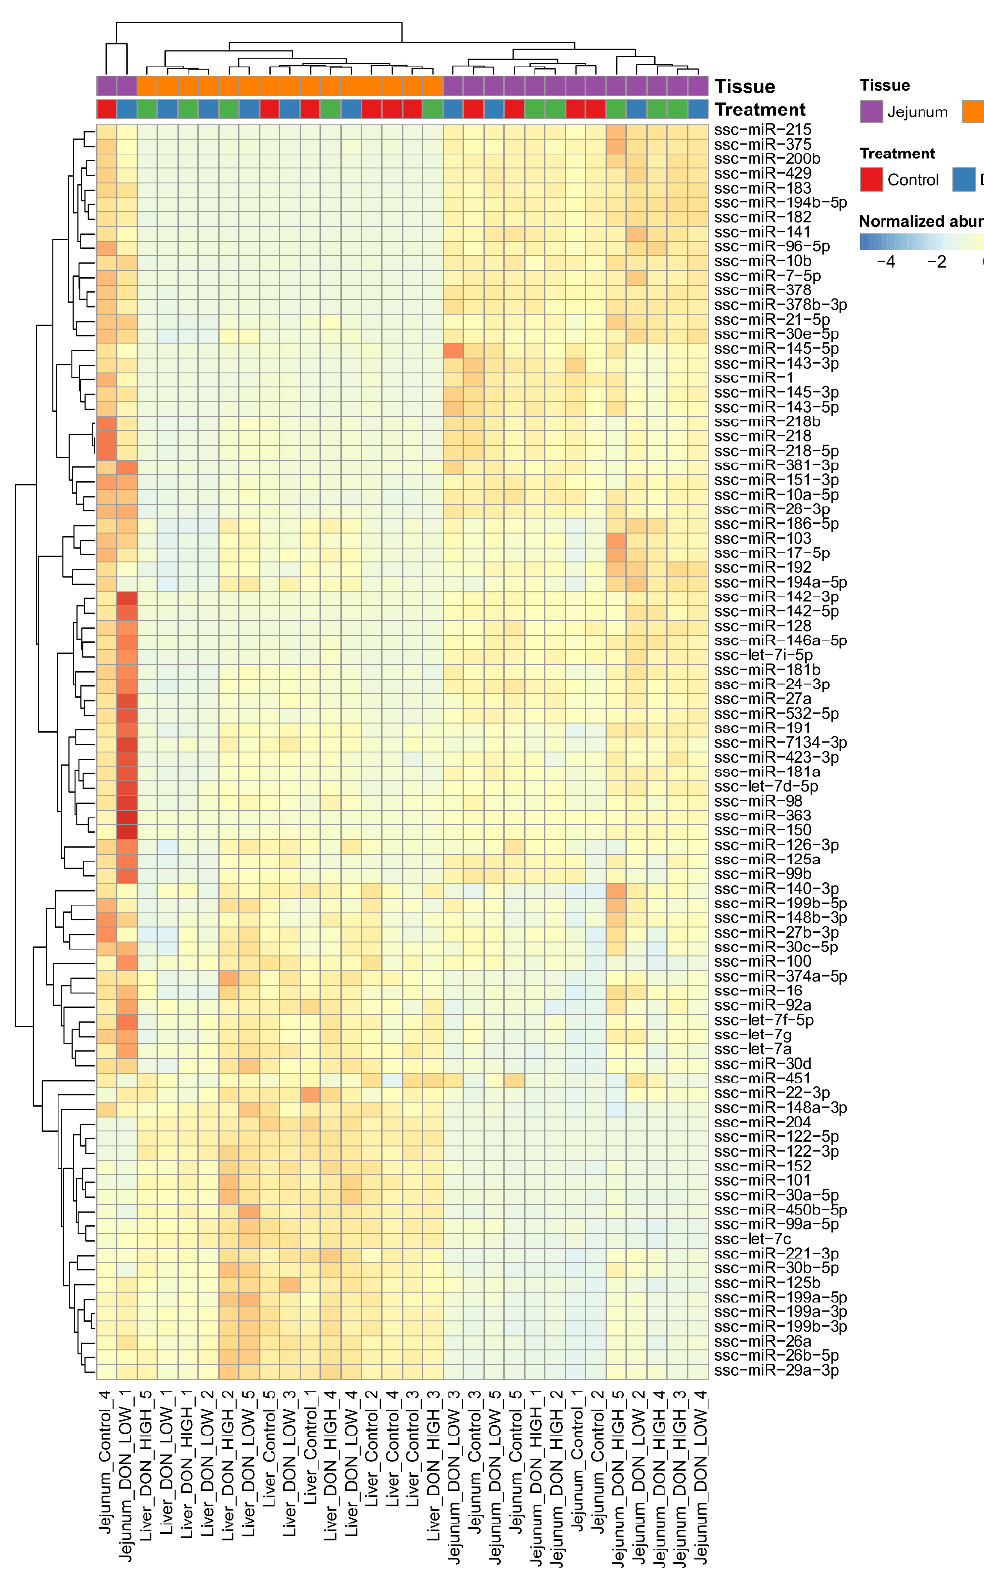
Figure 2. MicroRNA expression profiles of Control and DON exposed pigs in liver and jejunum. Heatmap of microRNA expression in all samples from the Control and DON exposed pigs.